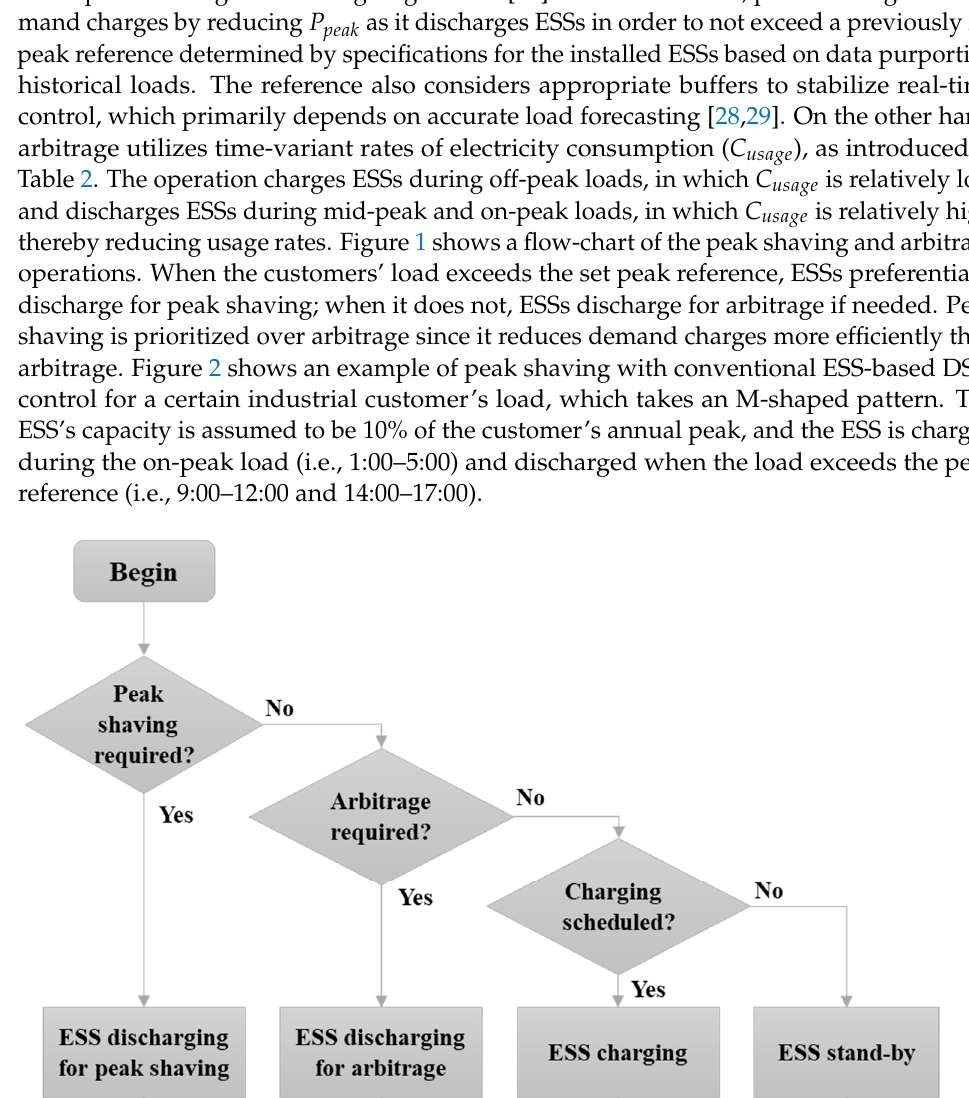
Figure 2. Example of the result of peak shaving with the conventional ESS-based DSM.